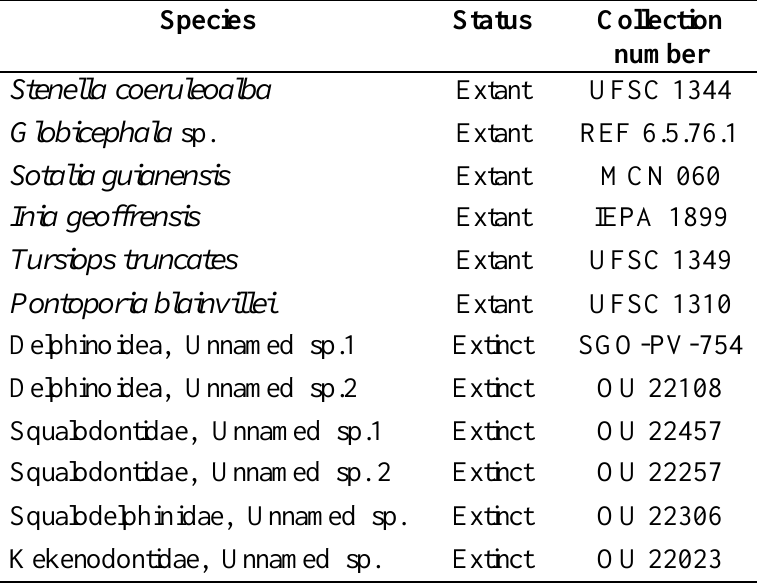
Table 1: Species and specimens analyzed and collection